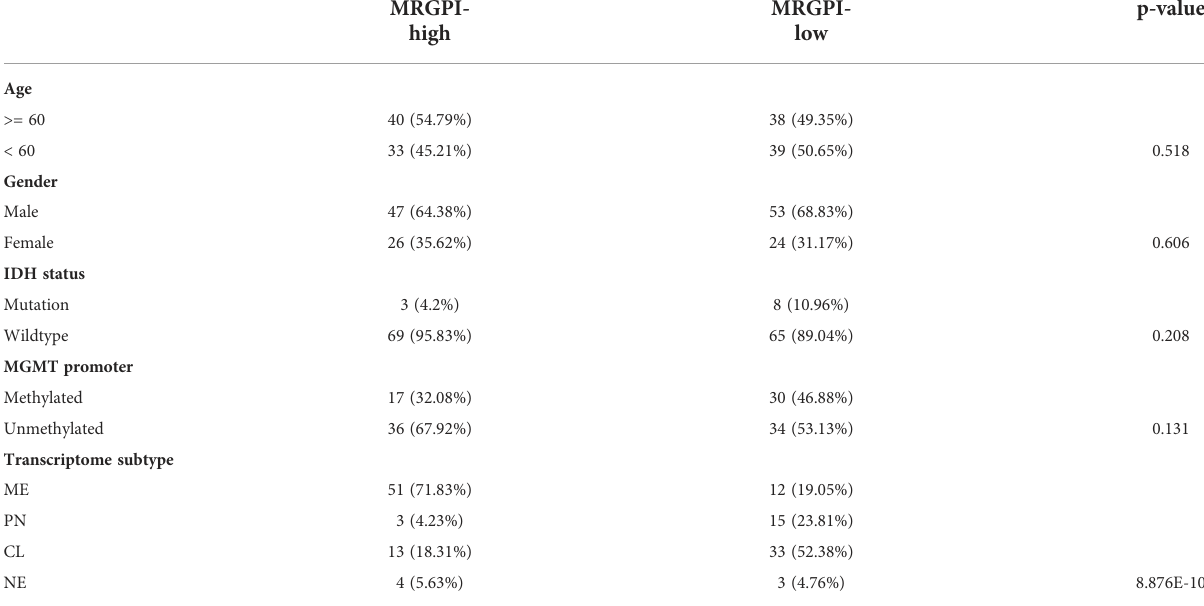
TABLE 1 Clinical features associated with MRGPI.